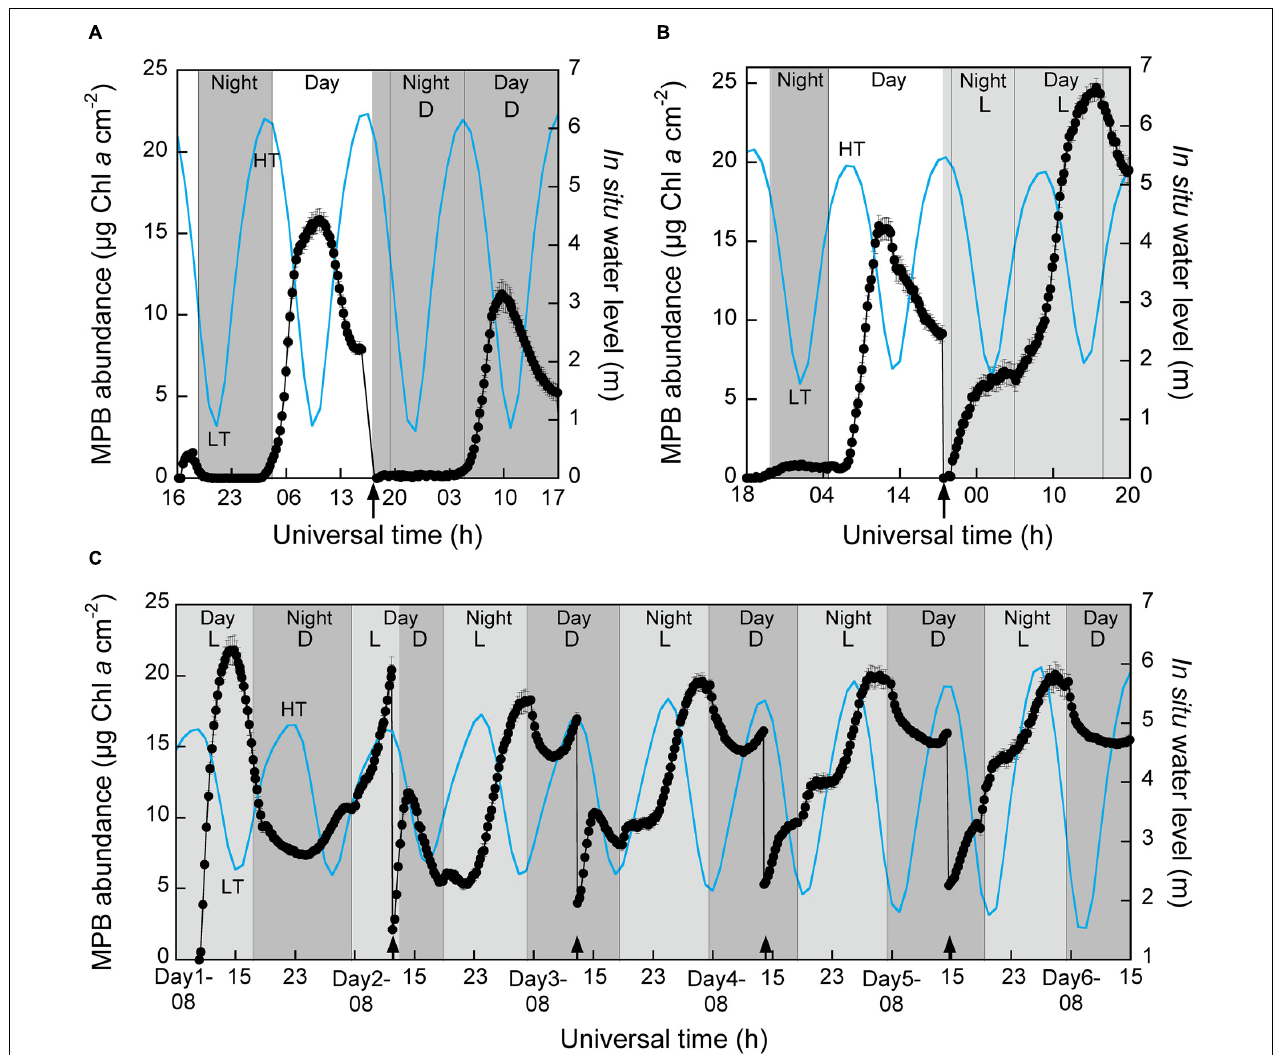
FIGURE 4 | Microphytobenthos abundance ( µ g Chl a cm − 2 ) at the surface of muddy sediment, and in situ water level (m) at the site of sampling as function of universal time (h UT), and monitored under different light regimes: (A) control light conditions for the first natural night/day period (“Night” and “Day” backgrounds) followed by artificial darkness (D) for the second night/day period; (B) control light conditions for the first natural night/day period followed by continuous artificial “white” light (L, 120 µ mol photons m − 2 s − 1 ) for the second night/day period, (C) artificial “white” light (L) followed by artificial darkness (D) for the first night/day period (Day 1), followed by artificially inverted night/day period (starting Day 2) for the four following days (Days 3–6). Low tide and HT, low tide and HT in situ timings, respectively, as in Figure 2 . Black line: MPB abundance ( µ g Chl a cm − 2 ); blue line: water level (m) at the site of sampling; dark gray and light gray backgrounds: the night and day periods, respectively; arrows indicate the timings for which the sediment was stirred with fresh seawater. Microphytobenthos abundance was derived from Chl a fluorescence ( F t level) as measured with an Imaging-PAM and HPLC analysis of Chl a sediment content ( Supplementary Figure S2 ); values are the mean ± SD of 5 Imaging-PAM “areas of interest” on the sediment tray. Water-level data were retrieved from the Service Hydrographique et Océanographique de la Marine (SHOM, France) database. See the Section “Materials and Methods” for further